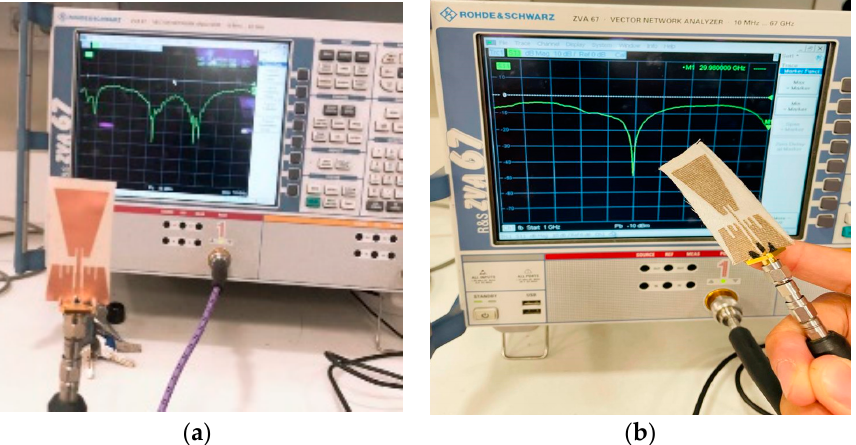
Figure 5. Full measurement setup of ( a ) flexible Roger substrate and ( b ) textile-based antenna connected to SMA cable at one side and other side to VNA.